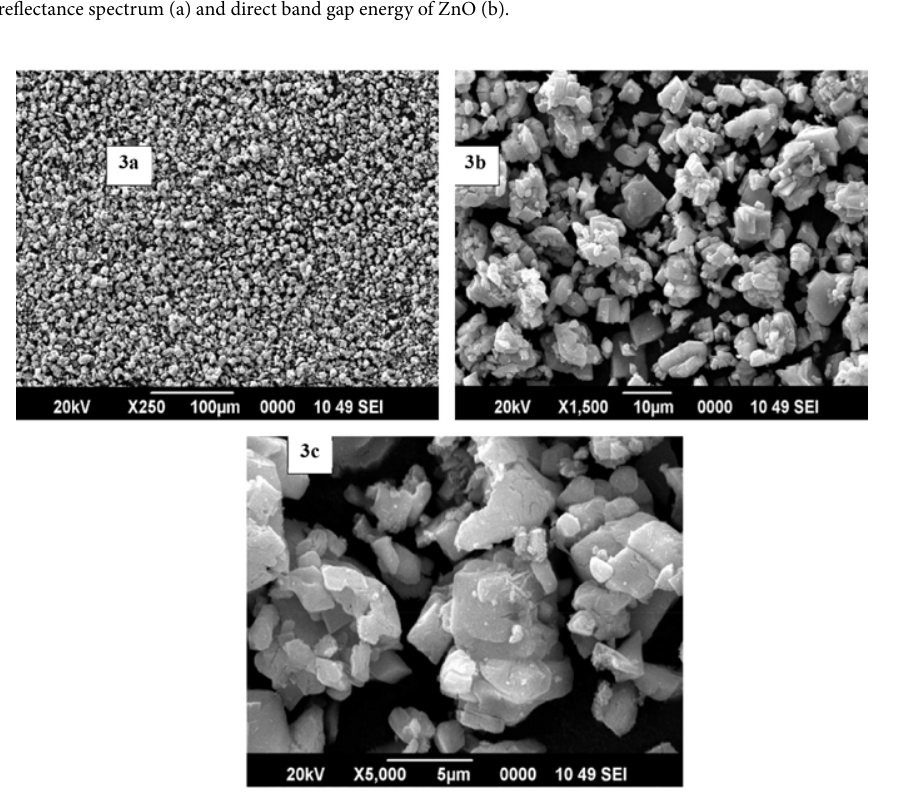
Figure 3. S EM image of ZnO